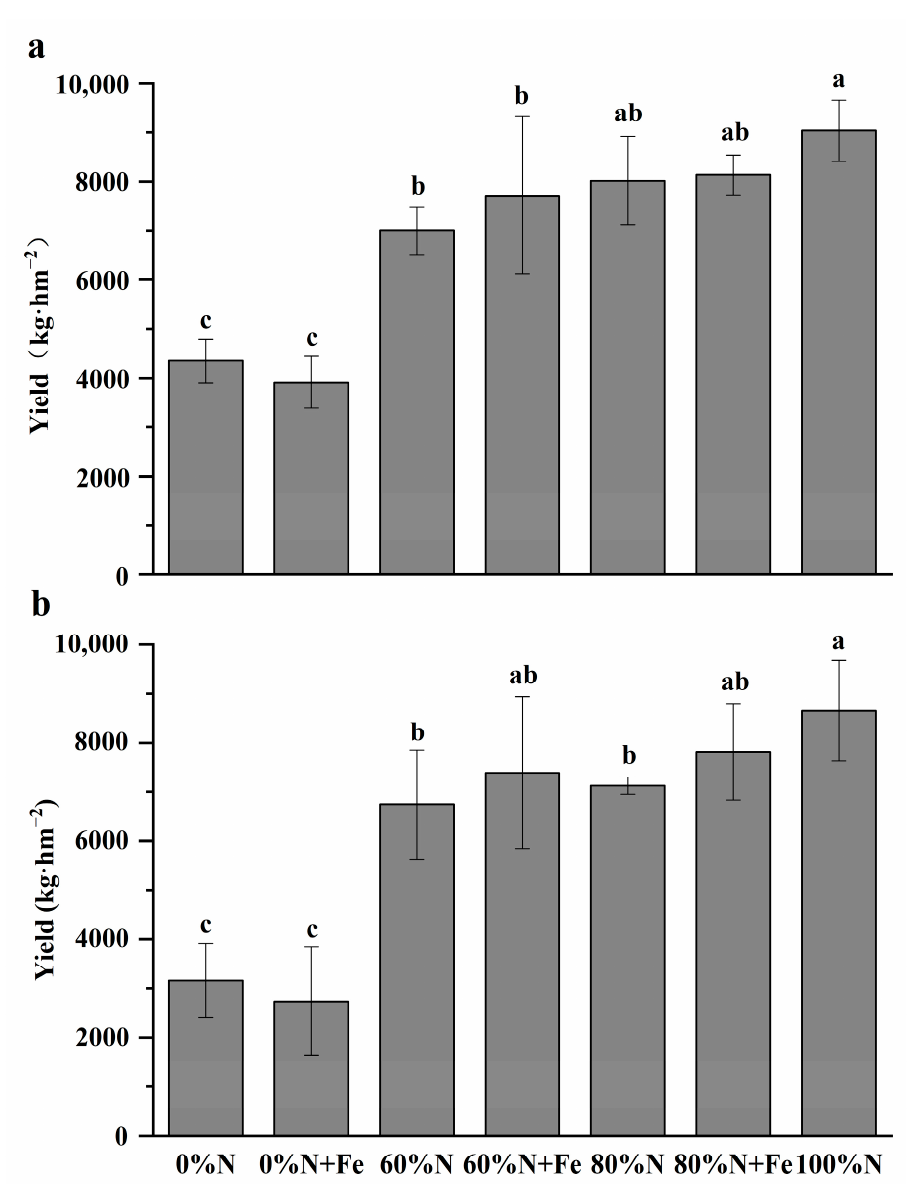
Figure 2. Rice yields under various nitrogen fertilization rates with or without iron amendment in 2019 ( a ) and 2020 ( b ). The conventional N fertilization rate (315 kg N hm − 2 season − 1 ) for rice in the lower Yangtze River Delta is 100%N. Fe was applied at 5000 kg hm − 2 as iron powder (>99% purity) when the field experiment started. Treatments that have the same letter above their bars (means ± SD, n = 4) are not significantly different at p < 0.05 as determined by analysis of variance (one-way ANOVA), followed by least significance difference (LSD) post hoc